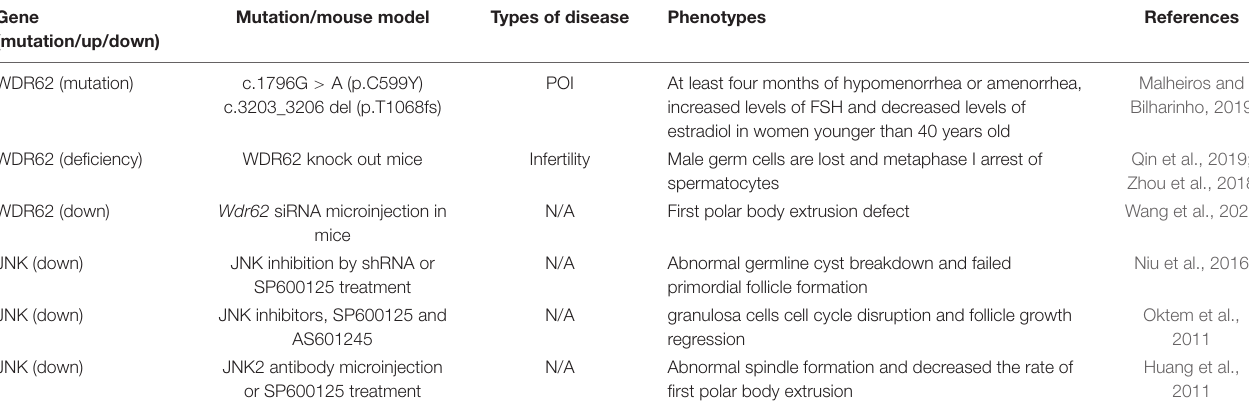
TABLE 2 | WDR62 and JNK signaling in reproductive